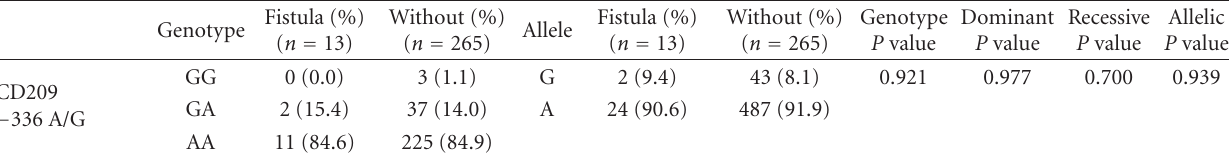
Table 4: Genotyping and allele frequency of CD209 − 336 A/G in patients with fistula or without fistula. Fistula (%) Genotype ( n =